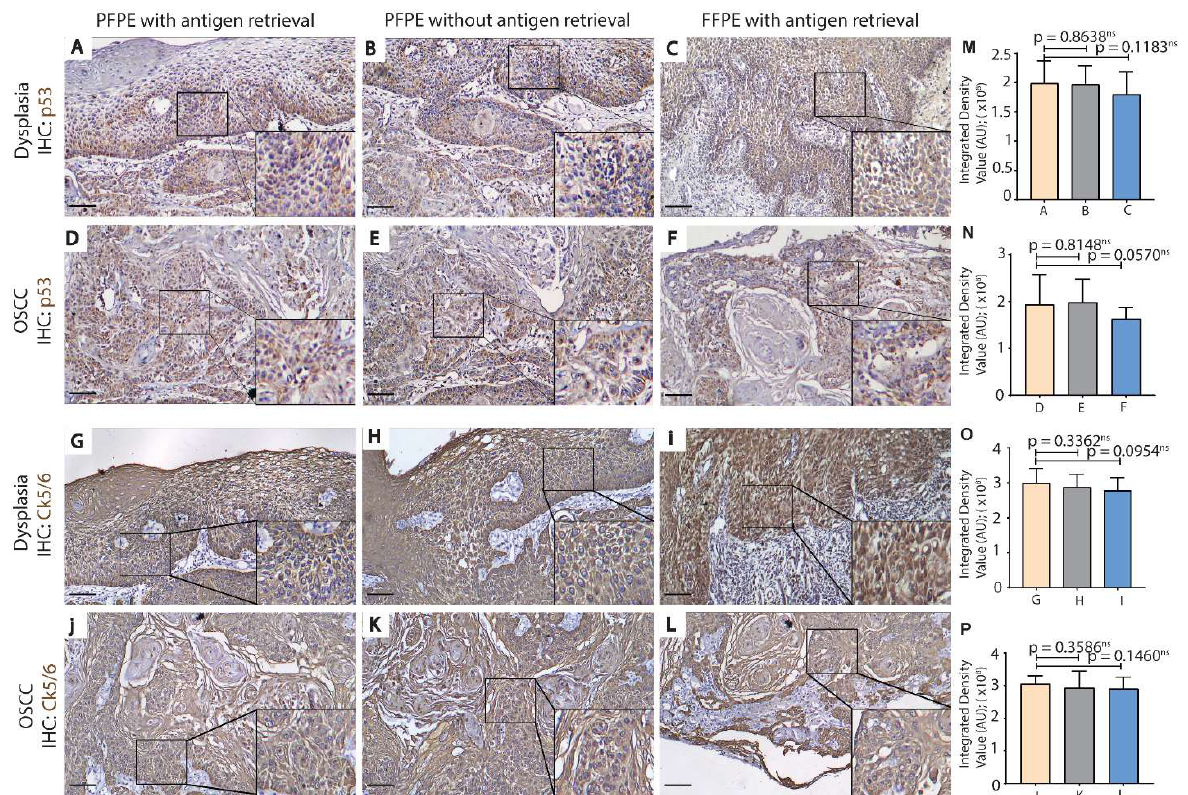
Figure 4. Heat-induced antigen retrieval is not essential for PFPE-Dysplasia and PFPE-OSCC tissues. Immunohistochemistry with antibodies against p53 ( A – F ) and CK5/6 ( G – L ) was performed on PFPE-Dysplasia ( A , B , G , H ), PFPE-OSCC ( D , E , J , K ), FFPE-Dysplasia ( C , I ), and FFPE-OSCC ( F , L ) tissues. Parallel tissue sections of PFPE-Dysplasia and PFPE-OSCC tissue were subjected to primary antibody (p53 or CK5/6) incubation with a prior antigen retrieval step ( A , D , G , J ) and without an antigen retrieval step ( B , E , H , K ). Antigen retrieval was performed on tissue sections of FFPE-Dysplasia ( C , I ) and FFPE-OSCC ( F , L ) before antibody (p53 or CK5/6) incubation ( C , F ). A similar intensity of the p53 immuno-staining was observed in basal and suprabasal layers of the epithelium in PFPE-Dysplasia tissues (corresponding integrated density value plot ( M ) for A – C ) with ( A ) or without antigen retrieval ( B ), and for FFPE-Dysplasia ( C ). CK5/6 immuno-staining was observed homogenously (corresponding integrated density value plot ( O ) for G – I ) through-out the epithelium in PFPE-Dysplasia tissues with ( G ) or without antigen retrieval ( H ), and for FFPE-Dysplasia ( I ). In PFPE-OSCC tissues, p53 immuno-expression ( D , E ) was found in epithelial islands and CK5/6 ( J , K ) immuno-expression was found in epithelial islands and keratin pearls, and the immunostaining and localization of both proteins were comparable to FFPE-OSCC tissues ( C , F , I , K ) (corresponding integrated density value plot ( N , P ) for G – I and J – L , respectively). The incubation time for DAB chromogen was 2.5 min for the p53 antibody and 1 min for the CK5/6 antibody. Magnification = 10 × ; Scale bar = 50 µ m. p < 0.0001 ***; p < 0.001 **; p < 0.05 * (student t -test). Abbreviations: FFPE, formalin-fixed paraffin embedded; PFPE, PAXgene-fixed paraffin